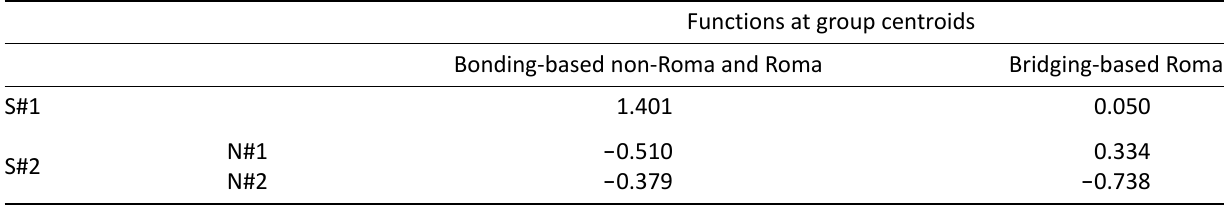
Table 6. The discriminant functions in the three areas